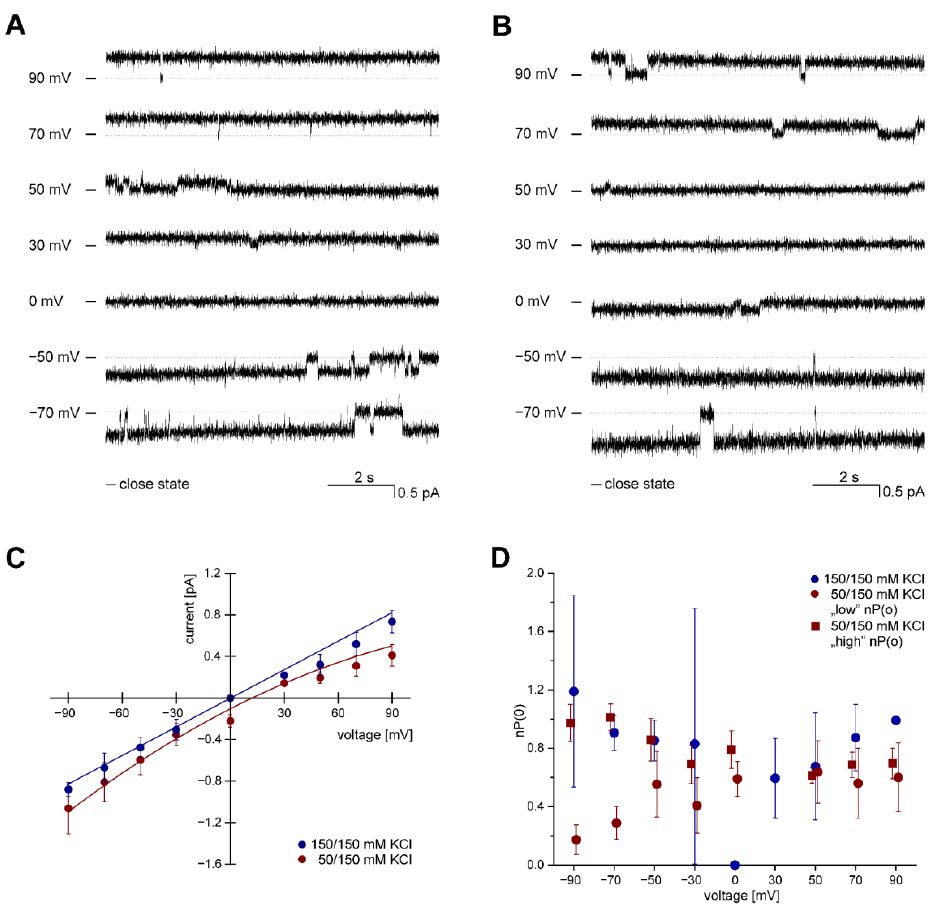
Figure 2. Functional characterization of the activity of ROMK2 channel reconstituted from polymer nanodiscs into planar lipid bilayers. ( A ) The representative activity of the ROMK2 channel at different voltages in symmetrical conditions. ( B ) The representative activity of the ROMK2 channel at different voltages in asymmetrical conditions. ( C ) Current-voltage characteristics of single ROMK2 channels in symmetrical (navy blue) ( n = 5) and asymmetrical (burgundy color) ( n = 45) conditions. ( D ) The dependence of the open probability of ROMK2 channels on voltage in symmetrical (navy blue) and asymmetrical (burgundy color) conditions. The channels that were recorded under asymmetrical conditions, based on their activity at negative voltages, were classified into two distinct groups: one with low nP(o) (represented by circles, n = 9) and the other with high nP(o) (represented by squares, n = 13) . “ - ” indicates a closed state of the channel.